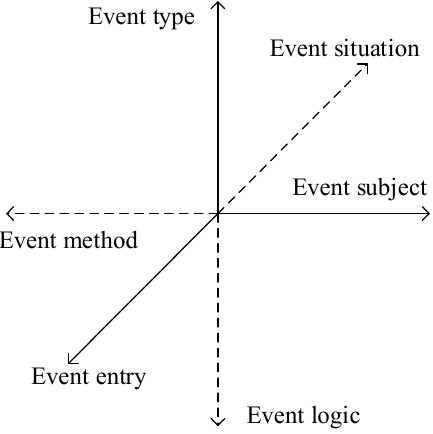
Figure 1. Each event is managed in accordance with a three-dimensional mirrored structure. Arrows indicate elements of the event.